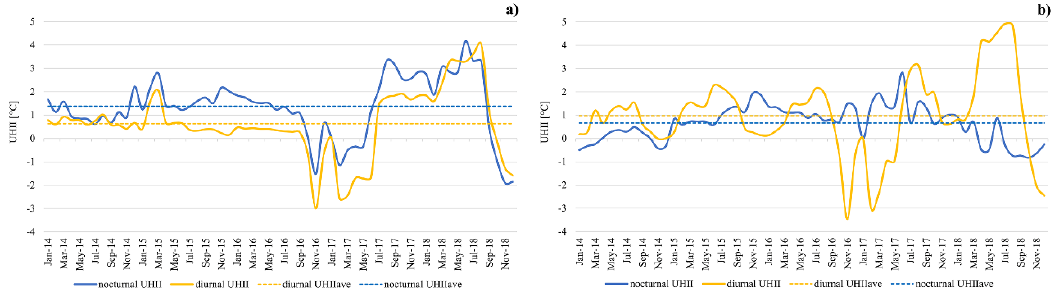
Figure 8. Diurnal and nocturnal UHII from 2014 to 2018, recorded at ( a ) station 2, and ( b ) station 3.